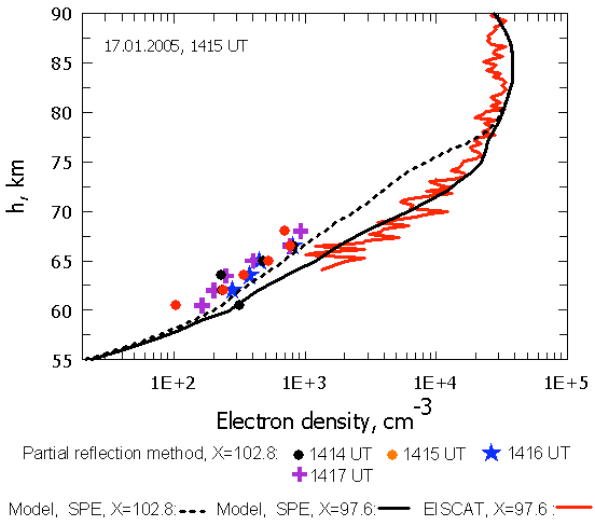
Fig. 12 . Effective recombination coefficient profiles calculated for the D-region at different solar zenith angles during the SPE on 17 January